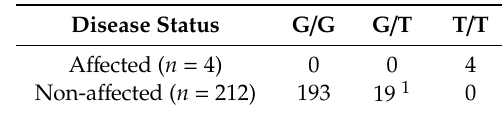
Table 1. Segregation of the SCN8A :c.4898G > T genotypes with spinocerebellar ataxia in Alpine Dachsbracke